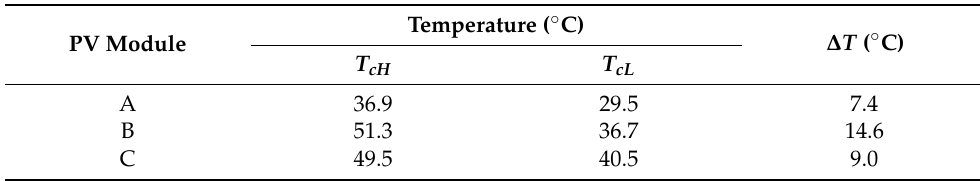
Table 3. Difference in temperature ( ∆ T ) of the solar cells with the highest temperature ( T cH ) and lowest temperature ( T cL ) for PV Modules A, B, and C which were affected by PID. PV